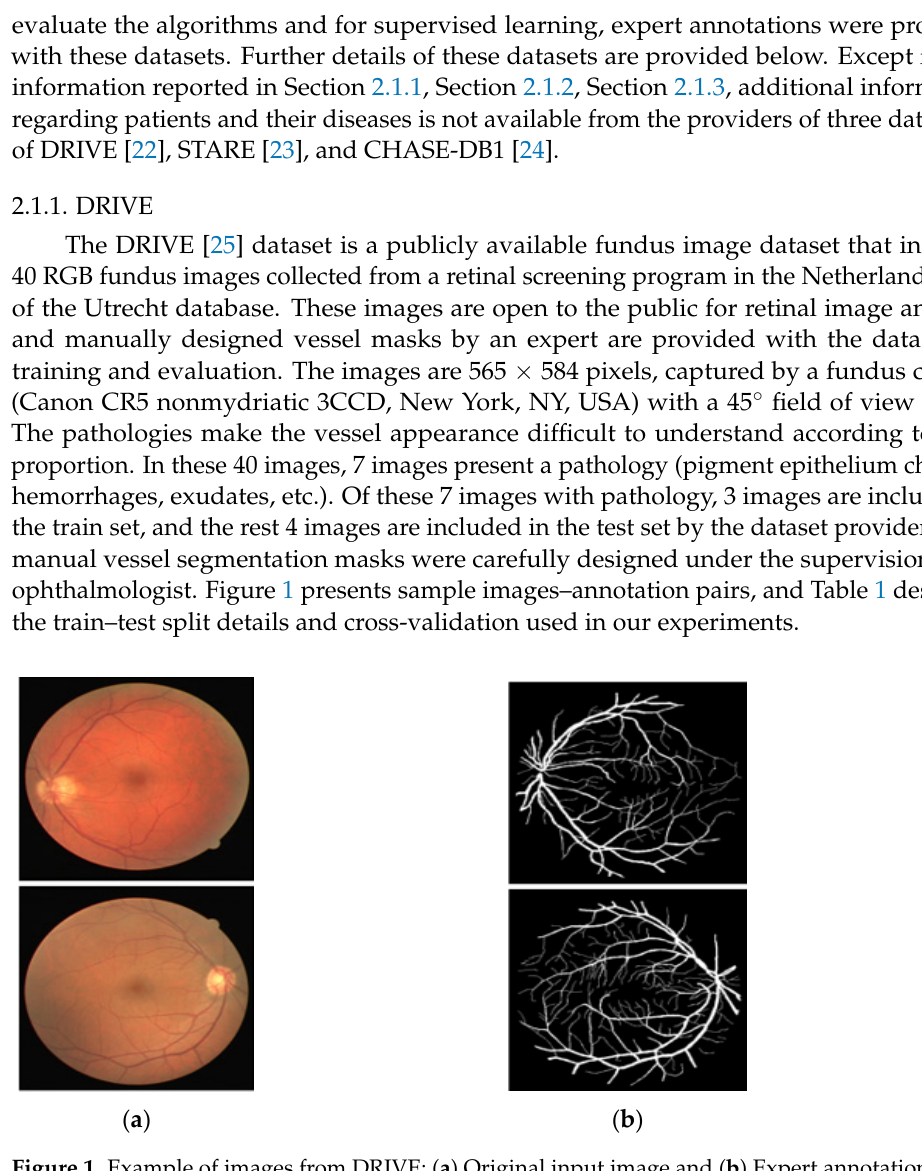
Figure 1. Example of images from DRIVE: ( a ) Original input image and ( b ) Expert annotation Mask. Table 1. Description of DRIVE, STARE, and CHASE-DB1 Datasets and Experimentation Details.